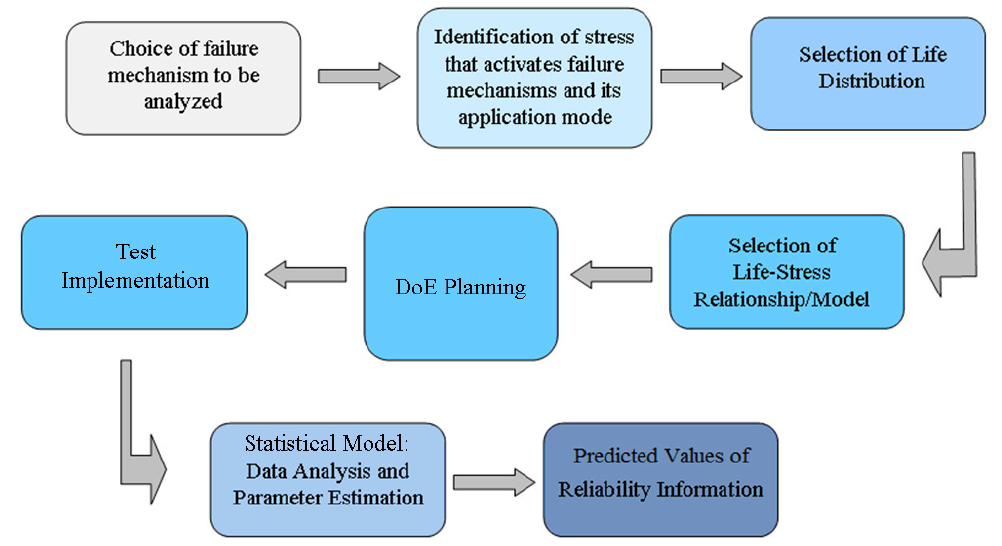
Fig. 1. Accelerated Life Testing flow